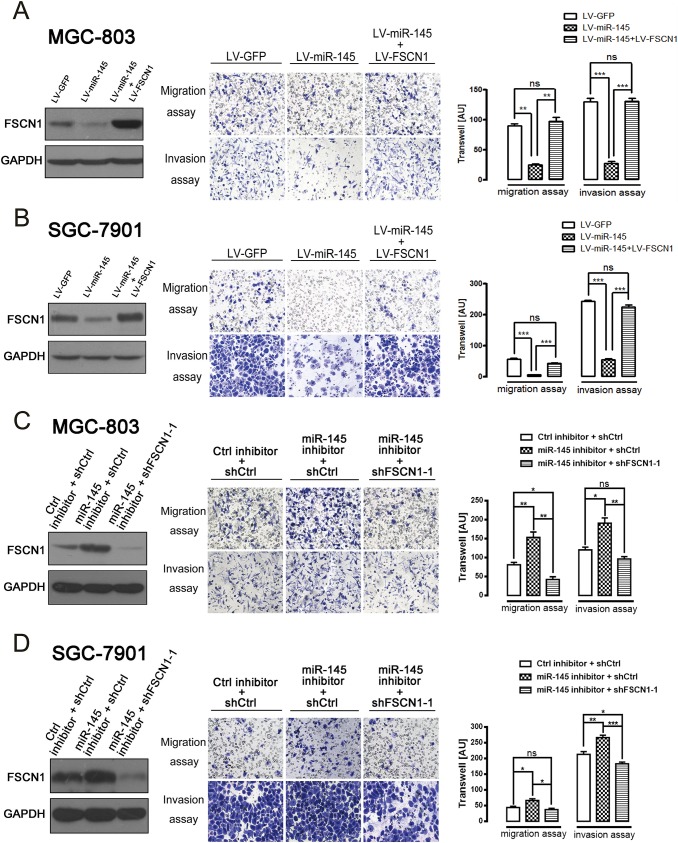
Repression of FSCN1 is necessary for miR-145 to inhibit the migration and invasion of gastric cancer cells.(A and B) Re-expression of FSCN1 compromised the miR-145-supressed cell migration and invasion ability in both miR-145-transfected MGC-803 (A) and SGC-7901 (B) cells. FSCN1 protein levels (left), representative images (middle) and cell counts (right) are shown. (C and D) Knockdown of FSCN1 compromised the miR-145 inhibitor-induced cell migration and invasion ability in both miR-145 inhibitor-transfected MGC-803 (C) and SGC-7901 (D) cells. FSCN1 protein levels (left), representative images (middle) and cell counts (right) are shown. AU: arbitrary unit. The data are presented as the mean±SD of three individual experiments (ns, not significant; *P<0.05; **P<0.01; ***P<0.001).